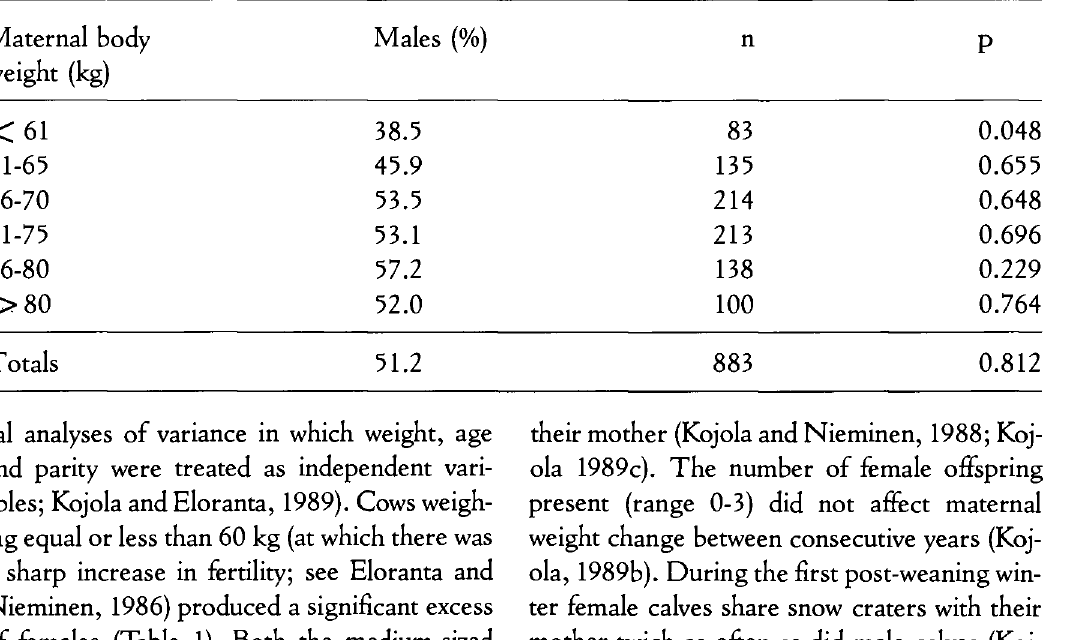
Table 1. Progeny sex ratio for mothers of different weight categories. P values are from binomial